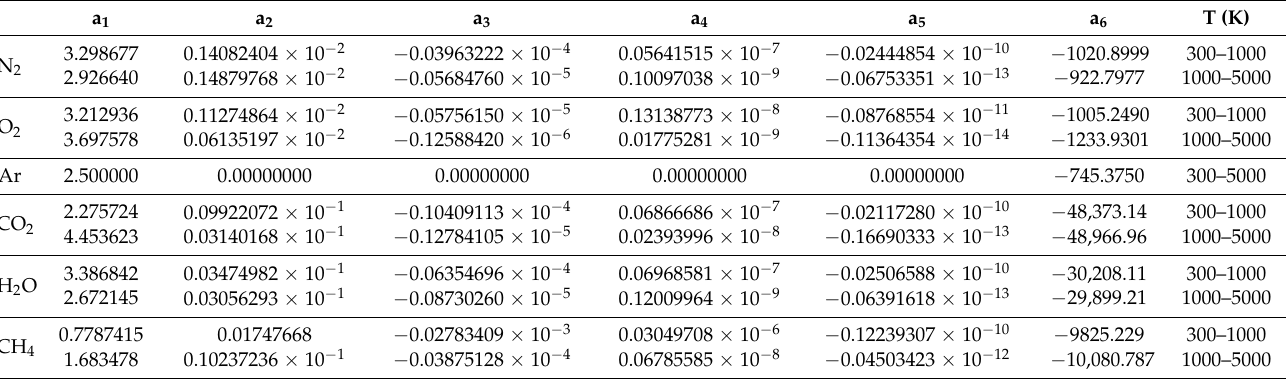
Table 1. Fitting